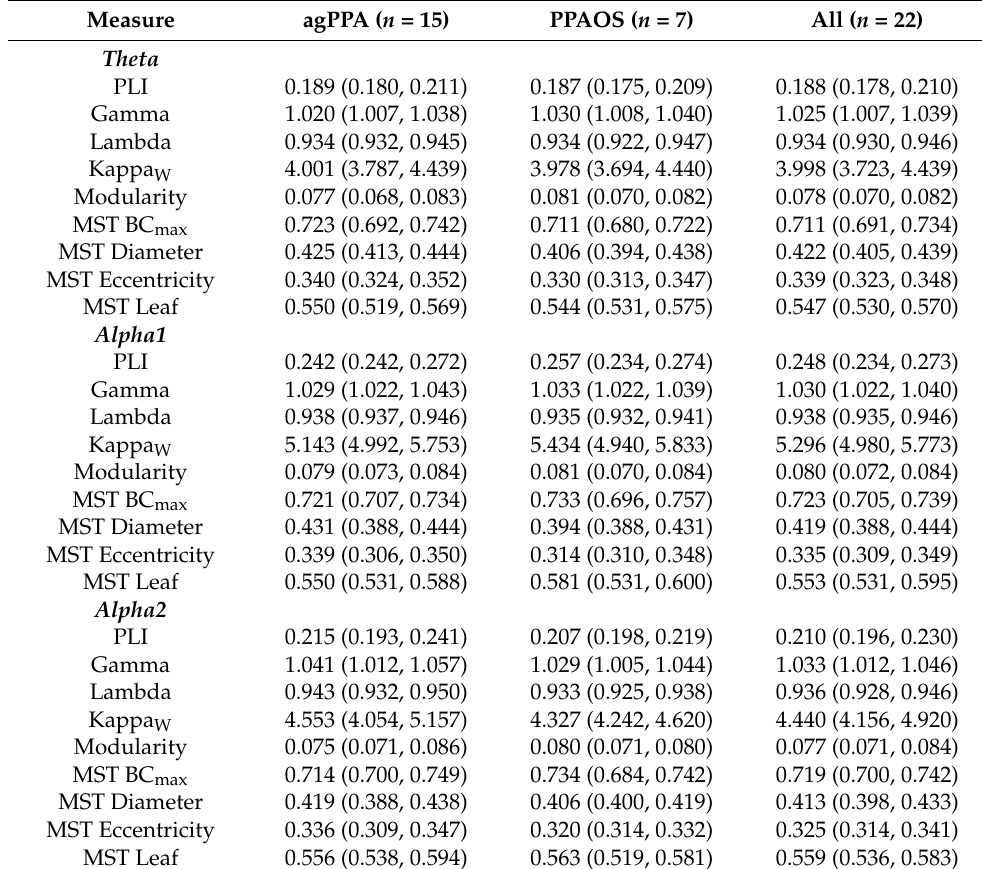
Table 3. Median (interquartile range) for group-level network measures.